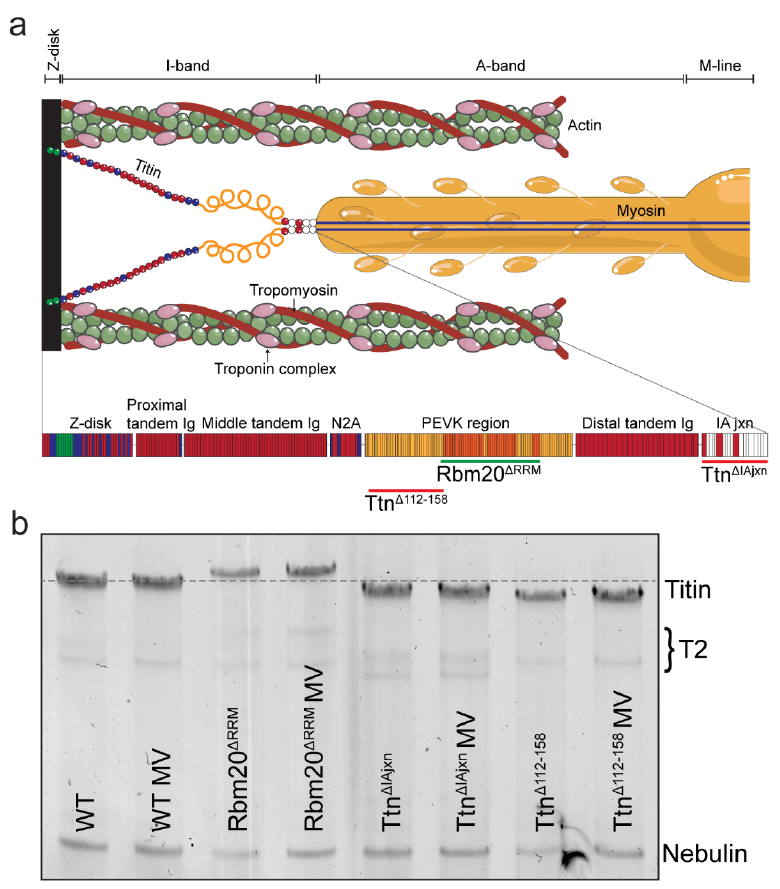
Figure 1. Titin migration for the different experimental models. ( a ) Layout of titin in the sarcomere. The N-terminal end of titin is anchored to the Z-disc, while the C-terminal end is anchored to myosin at the M-band. Below is a closer representation of the spring region of titin, between the Z-disc and IA-junction. The extra PEVK segments in the Rbm20 Δ RRM model are the orange domains, underlined in green. The deletions in the Ttn Δ IAjxn and Ttn Δ 112 − 158 mice are underlined in red. ( b ) Titin migration relative to nebulin, as determined by SDS-AGE is shown for Rbm20 Δ RRM , Ttn Δ IAjxn and Ttn Δ 112 − 158 mouse diaphragm respectively, for both non-ventilated and ventilated mice. A dotted gray line on the height of WT is indicated for reference. T2 indicates titin degradation products. For clearer representation of titin, contrast of the original scan was enhanced. The enhanced picture is shown here .